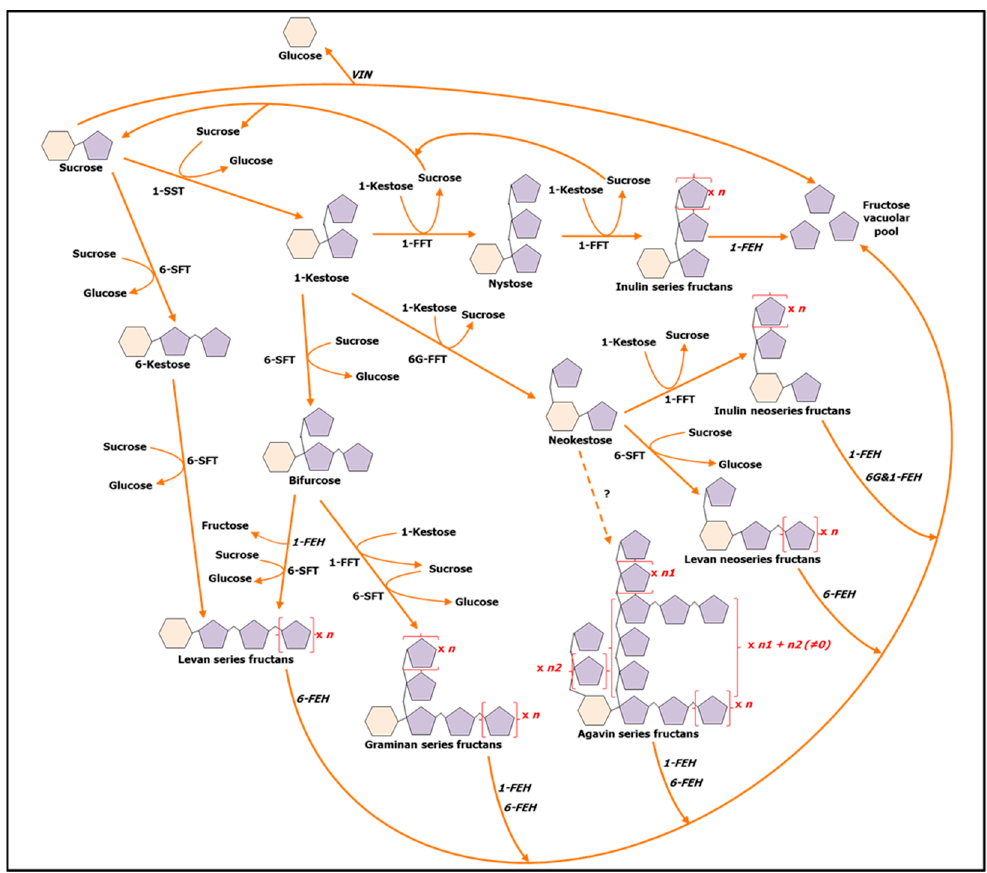
Figure 1. Schematic representation of fructan metabolism in plants. FEH = Fructan Exohydrolase; FFT = Fructan:Fructan Fructosyltransferase; SFT = Sucrose:Fructan Fructosyltransferase; SST = Sucrose:Sucrose Fructosyltransferase; VIN = Vacuolar Invertase. 1- and 6- prefixes of enzymes refer to the position of the C of the Fru moiety that is attacked by the enzyme. The 6G- prefix indicates that the enzyme acts on the C6 of the Glc moiety. All the described reactions take place in the vacuole [45,46]. The biosynthetic pathway of agavins are still under investigation. Although fructans are believed to be stored in the vacuole, their presence in the apoplast suggested a possible vesicular-mediated transport between the vacuole and the apoplast